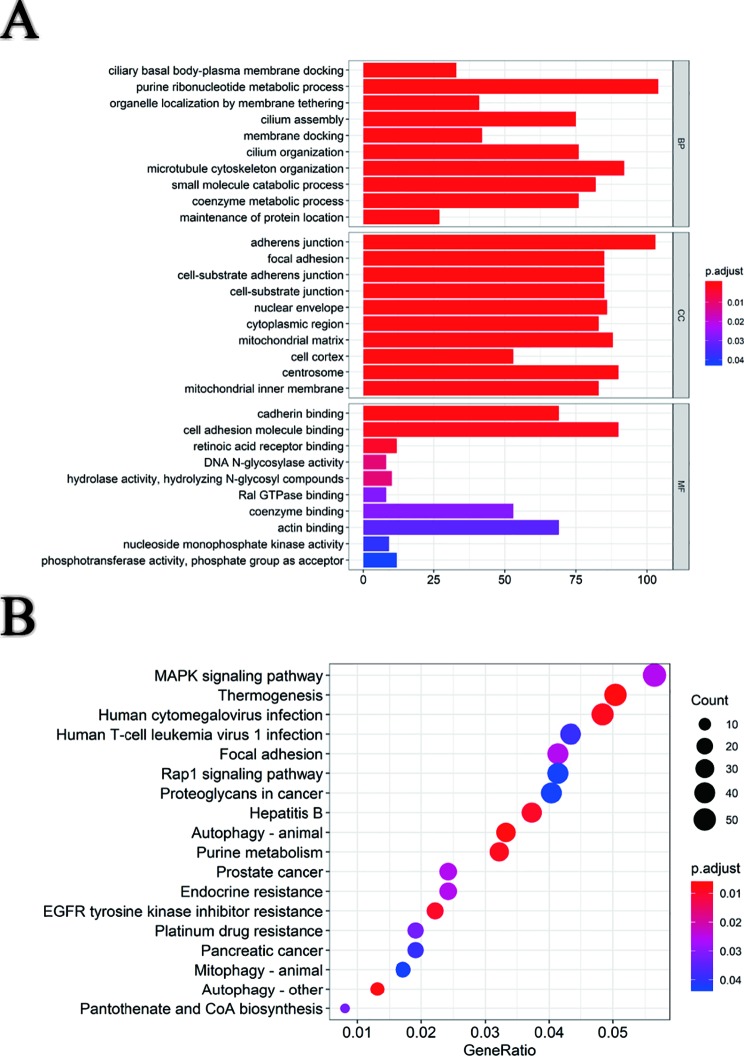
Functional and pathway enrichment analysis. (A) Gene ontology analysis of genes with survival-associated alternative splicing events. (B) Kyoto Encyclopedia of Genes and Genomes (KEGG) pathway analysis of genes with survival-associated alternative splicing events.